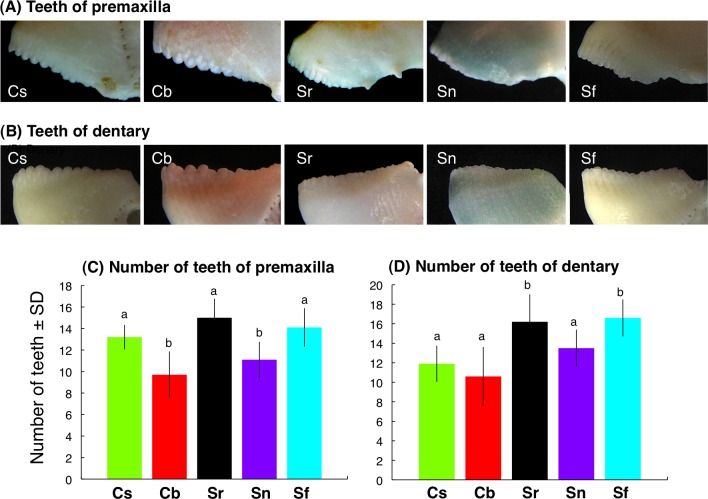
Photographs of teeth on dental plates of premaxilla (A) and dentary (B). Number of teeth on dental plates of premaxilla (C) and dentary (D). Different alphabet characters on the bars indicate significant difference (one-way ANOVA and post-hoc Games-Howell test, p < 0.05). Species names are abbreviated as Cs, Chlorurus sordidus; Cb, C. bowersi; Sr, Scarus rivulatus; Sn, S. niger; Sf, S. forsteni.